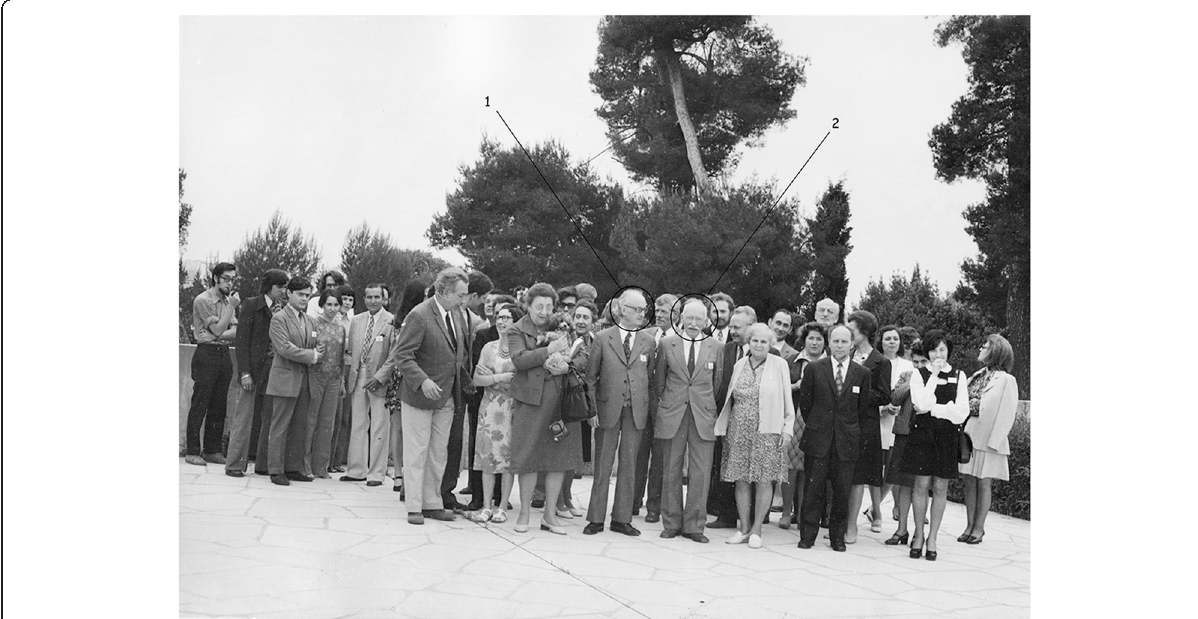
Figure 2 One of the photos taken during the IV International Congress of Arachnology which took place in Paris in 1968. M. Vachon (1) is next to P. Bonnet (2).